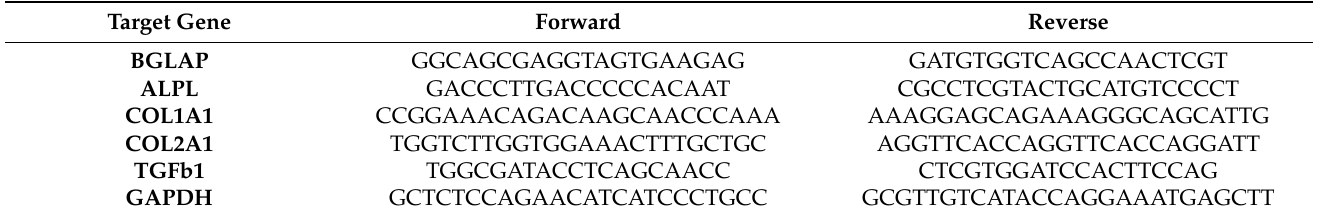
Table 2. qRT-PCR primer